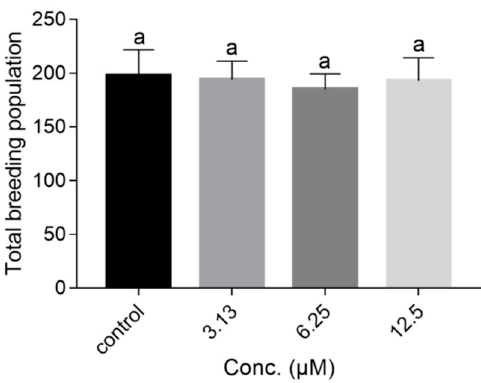
Figure 5. Effect of NOB on oviposition amount of C. elegans ( n = 5 animals per group). There were no significant differences in the number of total progeny between NOB-treated and untreated animals ( p < 0.05).